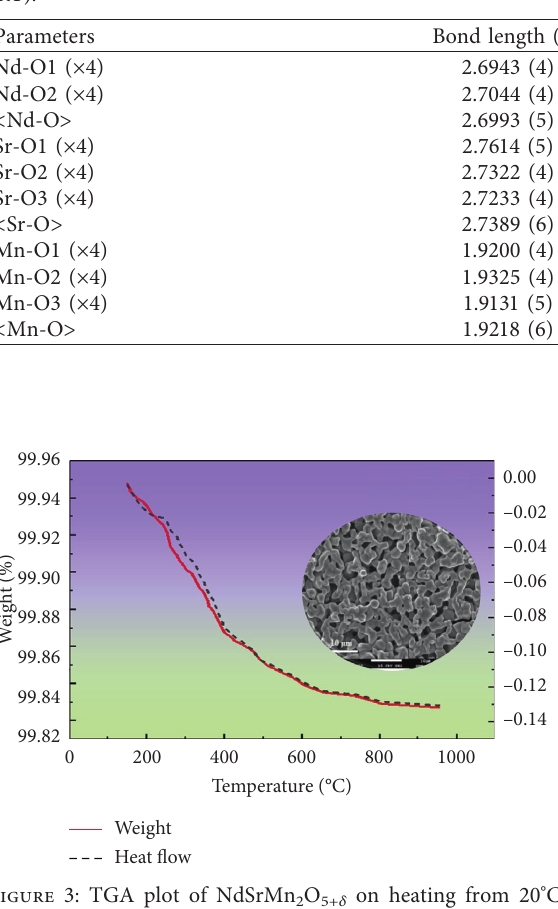
° C to 2 O 5+ δ on heating from 20